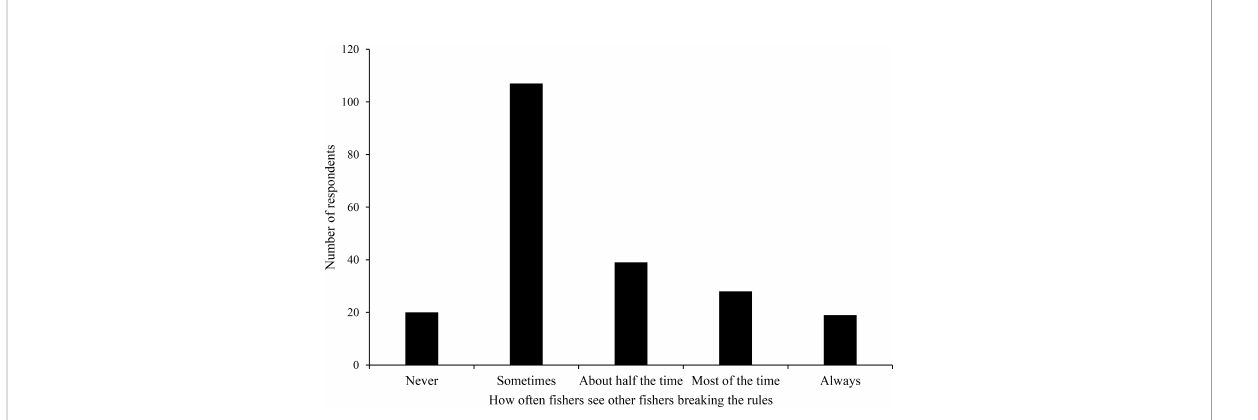
FIGURE 5 How often blue swimmer crab fi shers saw other fi shers in the Peel-Harvey blue swimmer crab fi shery who were not following the rules. Note: All 213 respondents answered the question. Respondents were only able to select one